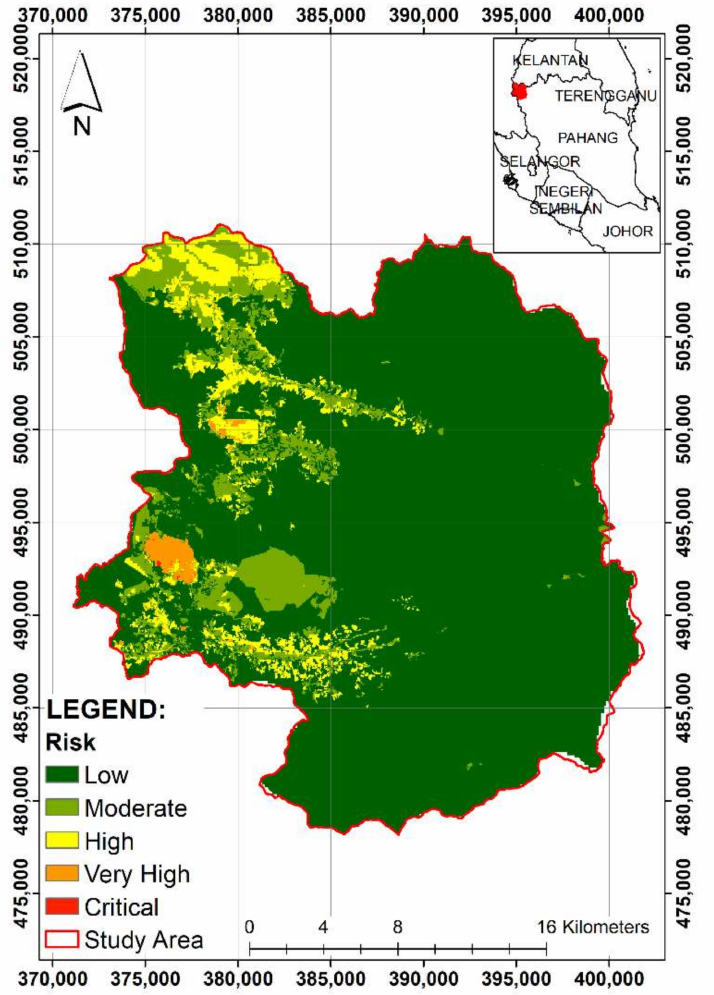
Figure 5. Annual average soil loss predicted in the study